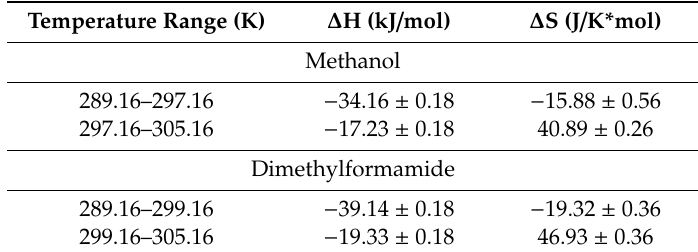
Table 2. Thermodynamic parameters associated to the complex formation of 1 with 6 in methanol or the DMF solvent.